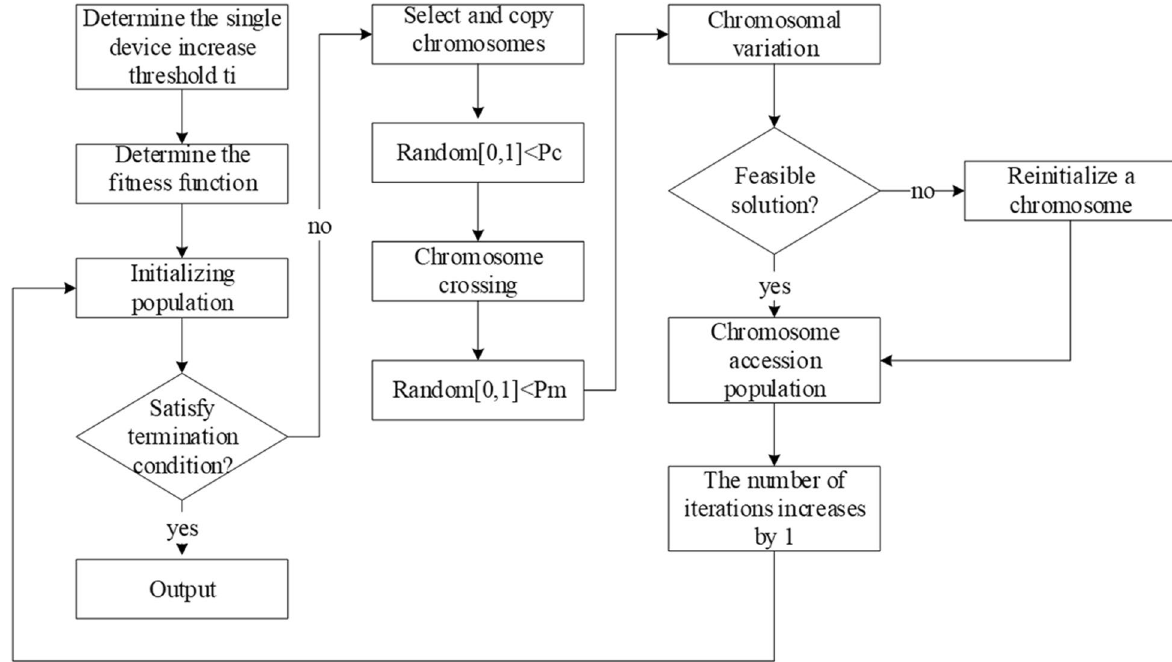
Fig. 6 Optimization method